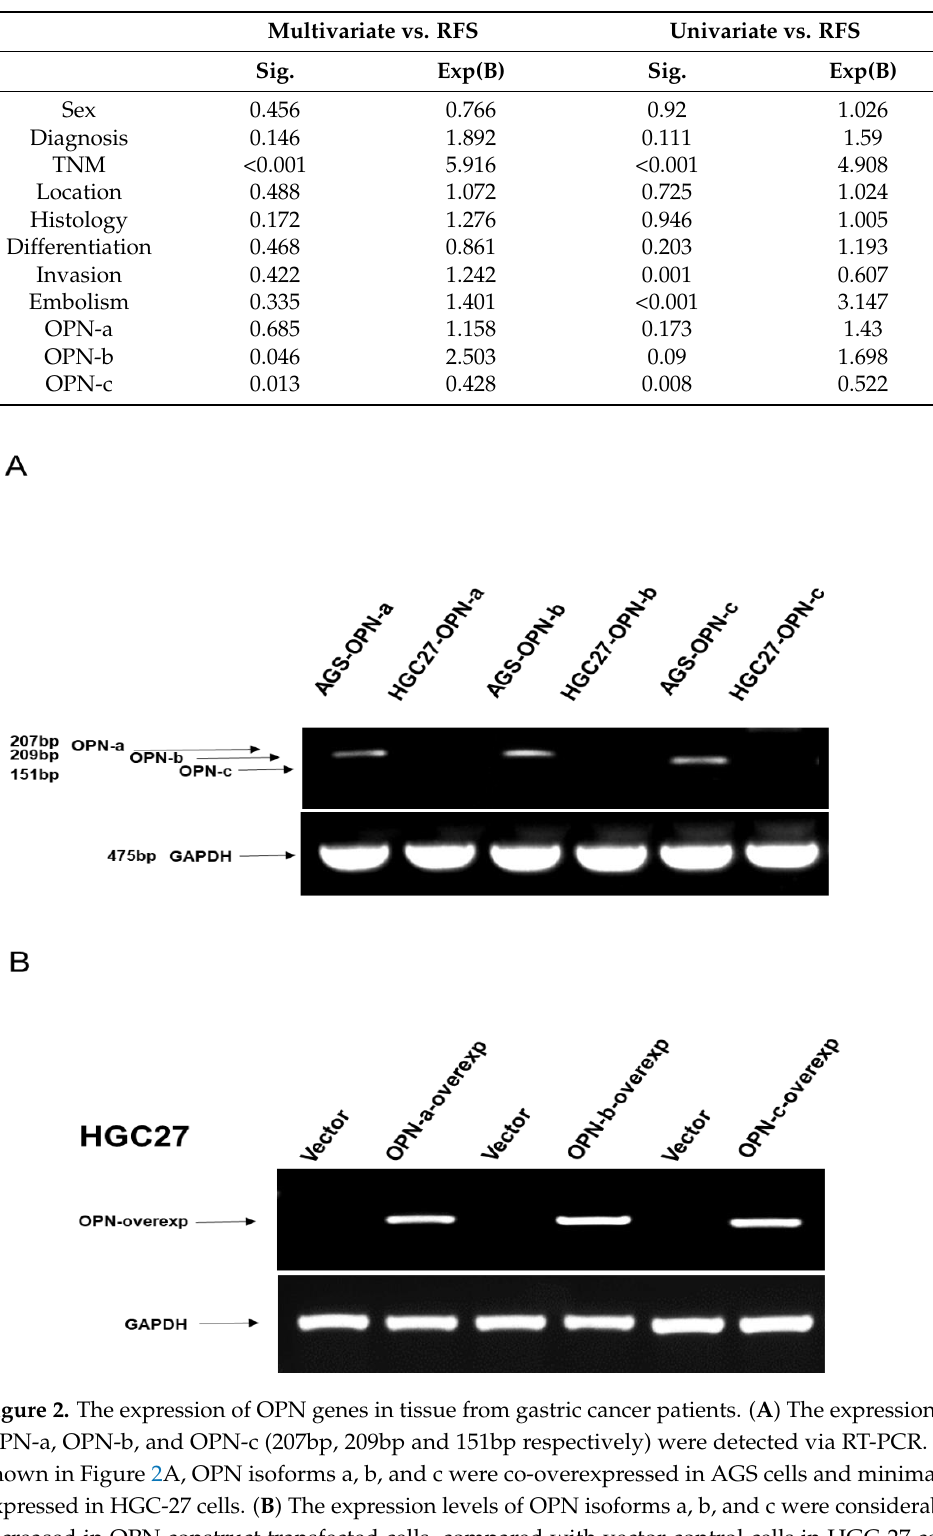
Table 4. Multivariate and univariate analysis of relapse-free survival (RFS). Exp(B), exponentiation of the B coefficient.